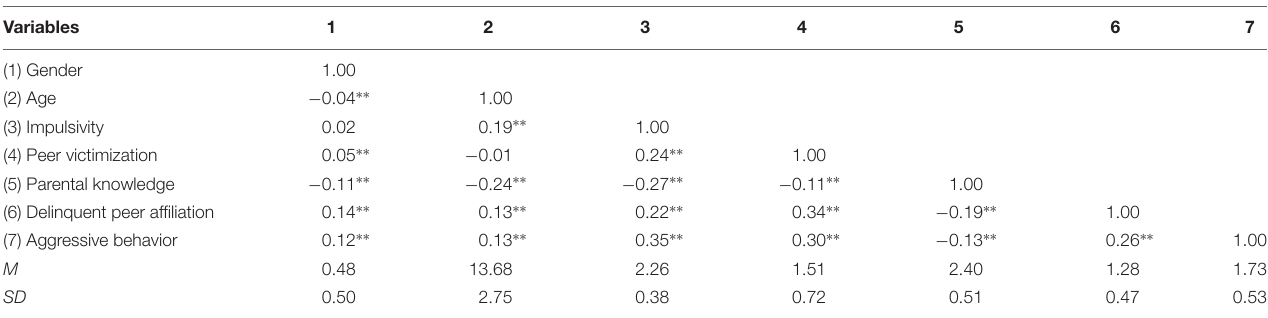
TABLE 1 | Means, standard deviations, and correlations of the main study variables.